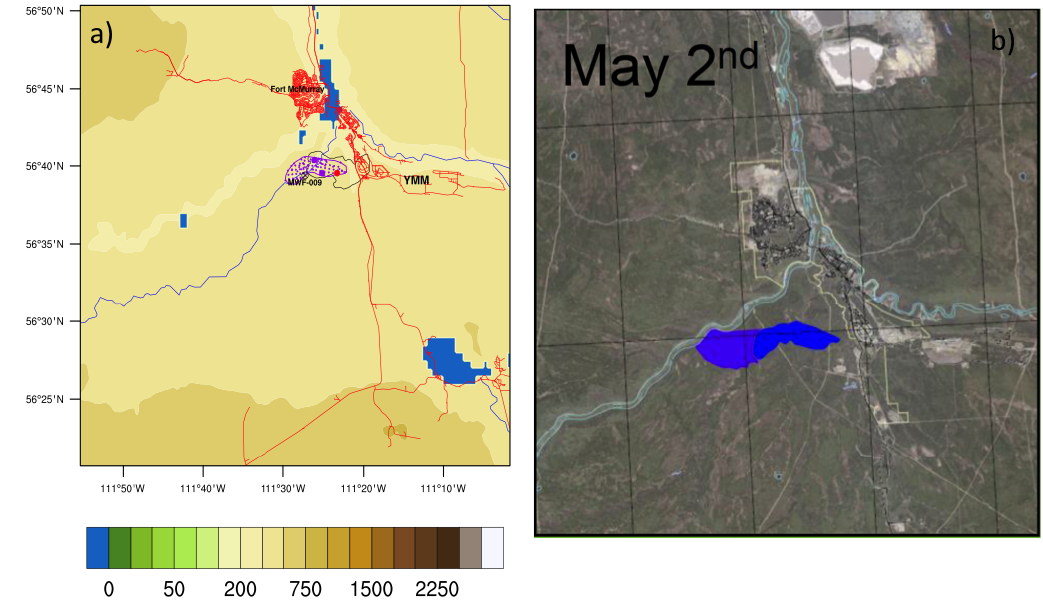
Figure 10. Burned area: left: overlay of WRF inner domain topography, burned area model output (black line), WRF ignitions (large purple and red circles), the earliest reported fire (MWF009-16) black circle and all detected 24 h hotspots on May 2, 2016. Right: burned area, courtesy of MWF-009-16, Alberta Parks report. The blue color presents the burned area on May 1. The dark purple-bluish shade is the burned area on May 2.